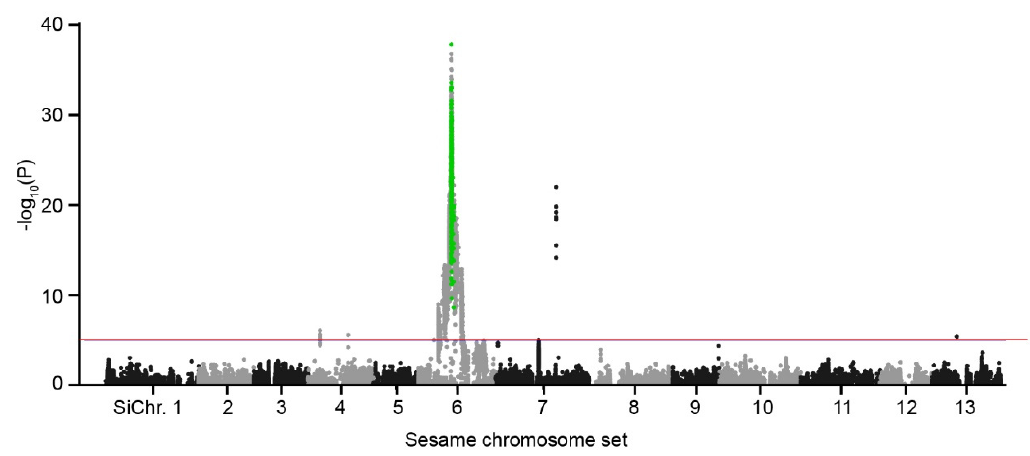
Figure 4. Cross-population association mapping of Sics1 gene locus in sesame. Manhattan plot of SNP/InDel association mapping of the MT is performed using a RIL population. The peak of -log 10 ( p ) is located on Si Chr. 6. After screened using the genome variants data, 156 variants (green dots) are retained as the candidate markers associated with the MT. Note: each dot (black, grey and green) represents a SNP/InDel variant. Red line refers to cutoff used in association mapping.